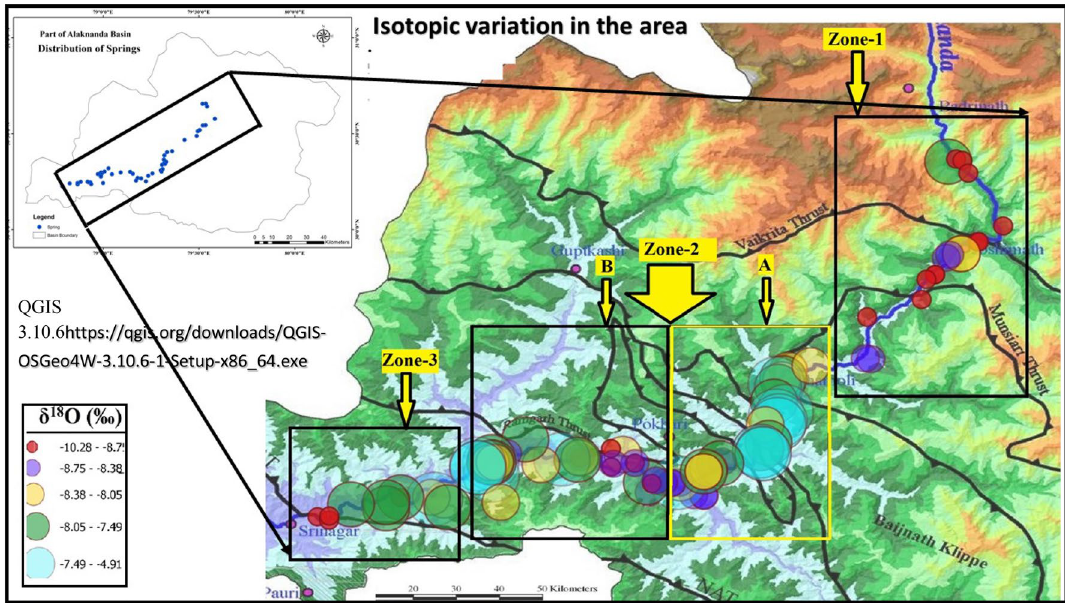
Figure 4. δ 18 O (‰) variation/diversity within the zones (1, 2, 3) and in compartmentalised Zone-2 (i.e., A and B ) georeferenced and modified after (Shukla et al. 17 ). A and B in Zone-2 accounts for maximum species of δ 18 O (‰) compared to Zone-1 and